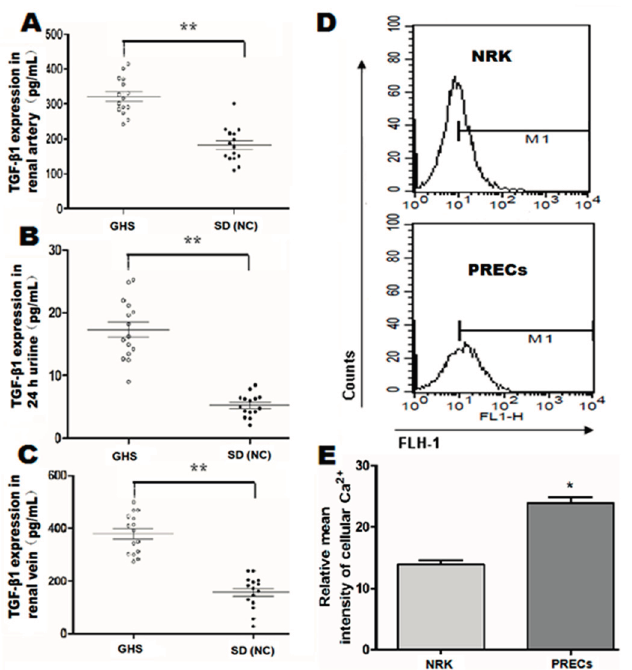
Figure 1. Quantitative analysis for baseline levels of cytokines TGF- β 1 in renal serum and 24-h urine samples in genetic hypercalciuric stone-forming (GHS) rats and calcium ion concentrations in isolated primary renal tubular epithelial cells (PRECs). TGF- β 1 in renal artery ( A ), 24-h urine ( B ) and renal vein ( C ) was analyzed by enzyme-linked immunosorbent assay (ELISA) using rat ELISA kits in fifteen GHS rats comparing with corresponding TGF- β 1 contents in fifteen age- and weight-matched normal control (NC) Sprague Dawley rats, respectively. ** p < 0.01; ( D ) representation of intracellular Ca 2+ concentration detection by flow cytometric analysis in isolated PRECs from GHS rats and corresponding normal control NRK cells; ( E ) mean intensity of Fluo-3/AM fluorescence in the PRECs and NRK groups ( n = 5). * p <